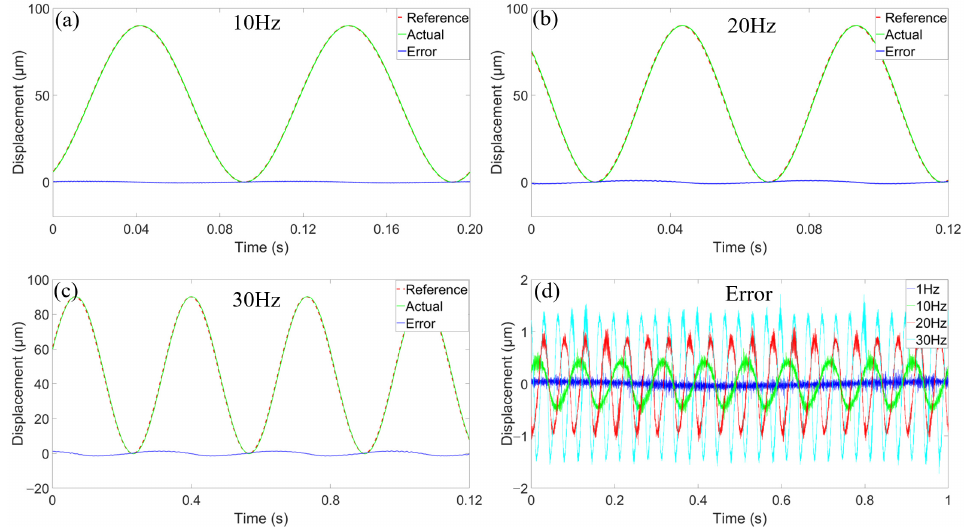
Figure 11. Trajectory tracking results. ( a ) Sinusoidal signal with a frequency of 10 Hz. ( b ) Sinusoidal signal with a frequency of 20 Hz. ( c ) Sinusoidal signal with a frequency of 30 Hz. ( d ) Trajectory tracking